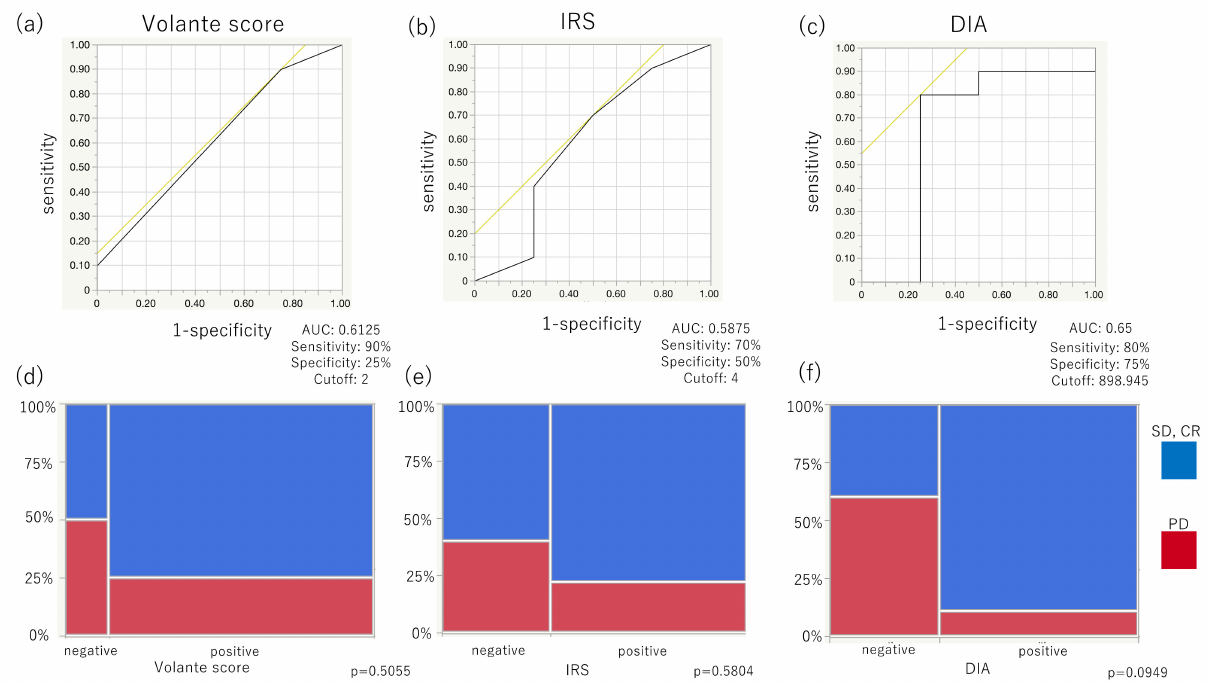
Figure 4. SSTR2 immunoreactivity was evaluated by three different scoring systems and their correlation with the therapeutic efficacy of SSAs in Group 3 patients. ( a – c ) The area under the curve (AUC) was highest when evaluated using DIA (AUC, 0.65; cut-off, 898.945; sensitivity, 80%; specificity, 75%), compared with that when using Volante scores (AUC, 0.6125; cut-off, 2; sensitivity, 90%; specificity, 25%) and IRSs (AUC, 0.5875; cutoff, 4; sensitivity, 70%; specificity, 50%). ( d – f ) Higher proportions of SD or CR were detected in positive cases than in negative cases regardless of the scoring systems used. ( f ) SSTR2 immunoreactivity evaluated by DIA tended to be closely associated with the therapeutic efficacy of SSAs, but not when evaluated using the Volante scores and IRSs.